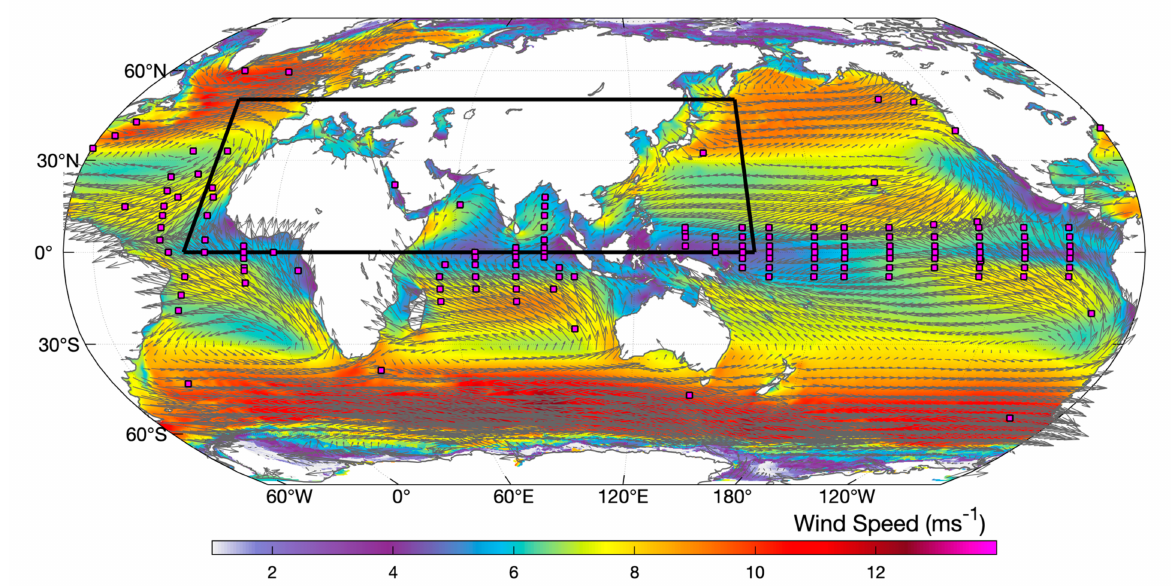
Figure 2. Mean global wind speed (colored background) and direction vector averaged over 1988–2018. The superimposed magenta squares denote the locations of moored surface buoys used as validation (NDBC buoys are not shown). The large black box denotes the focal area of this